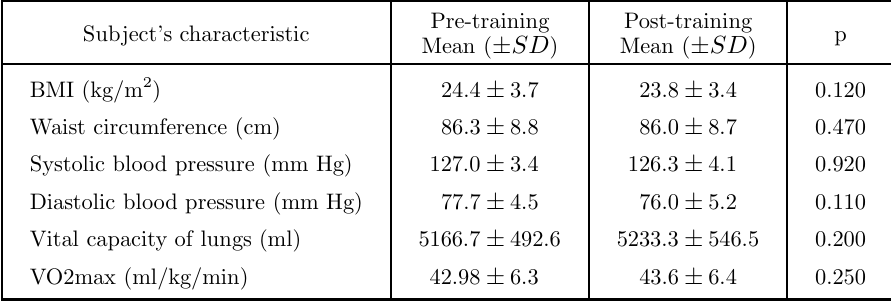
Table 1. Male characteristics pre-training and after 30 weeks of SAT (n = 6) Pre-training